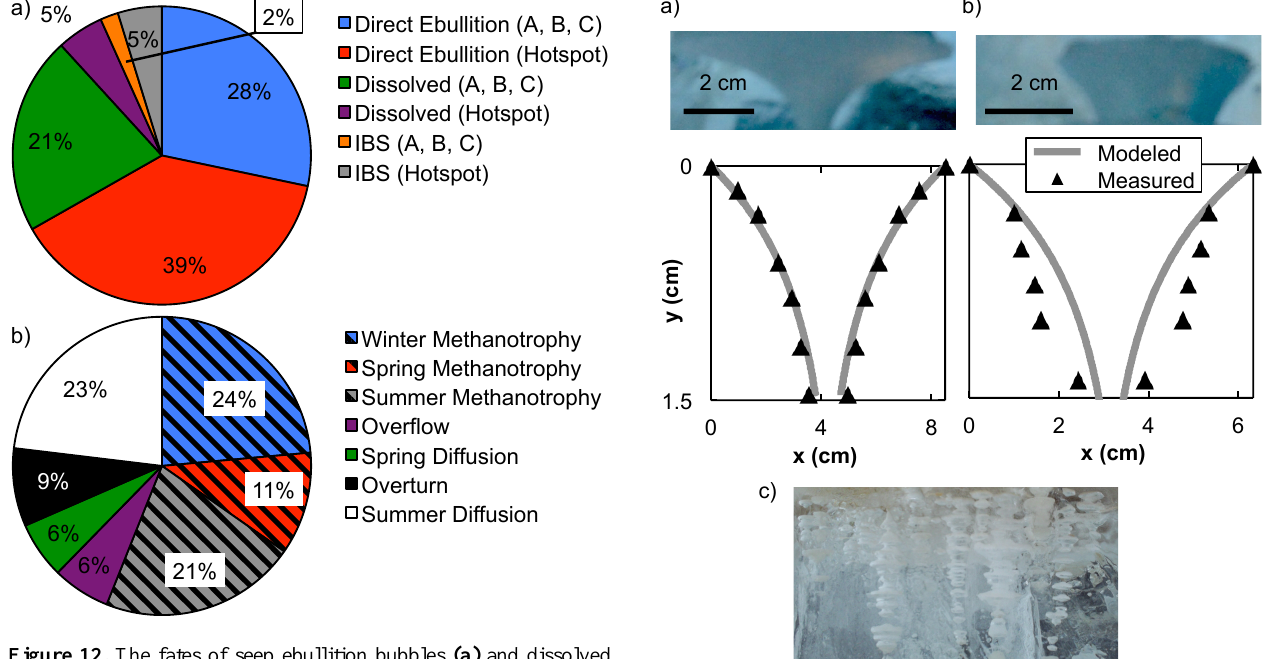
Figure 12. The fates of seep ebullition bubbles (a) and dissolved CH 4 (b) during the 2-year study period, as calculated in the base- line version of the model. The names of the various modes of CH 4 emission are discussed in Sect. 3.2. Figure 13. The shapes of bubbles encapsulated by lake ice above an